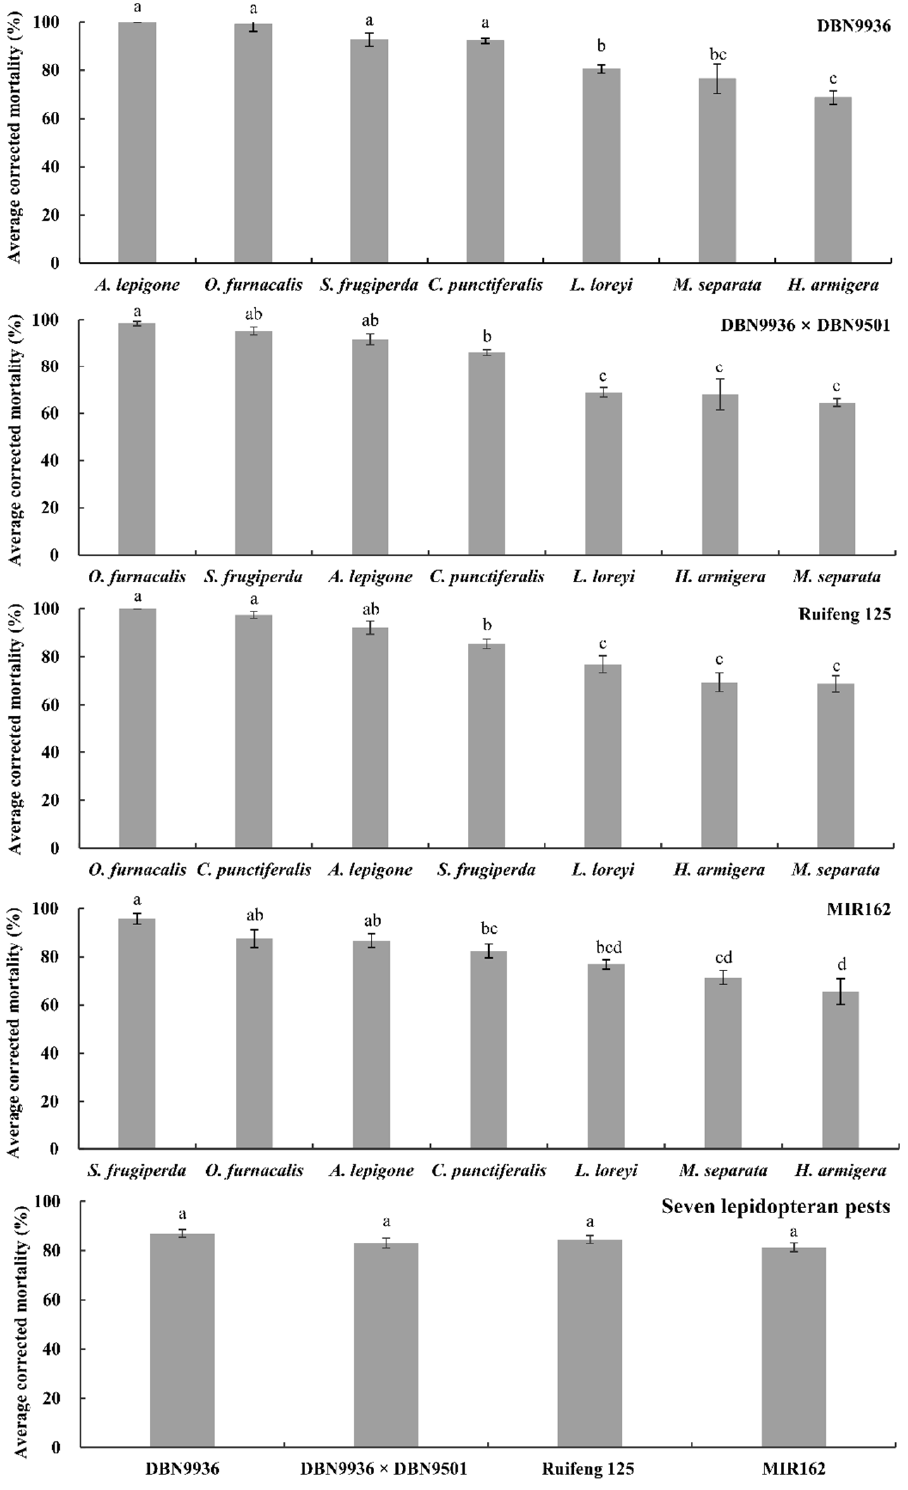
Figure 5. Average corrected mortalities of neonates for seven lepidopteran pests on artificial diet containing lyophilized different tissues of insect-resistant maize transformation in different growth stages at a 25-fold dilution relative to the isogenic negative control. Values represent means ± SE. Different lowercase letters above bars indicate significant difference by Duncan’s multiple range test ( p < 0.05).